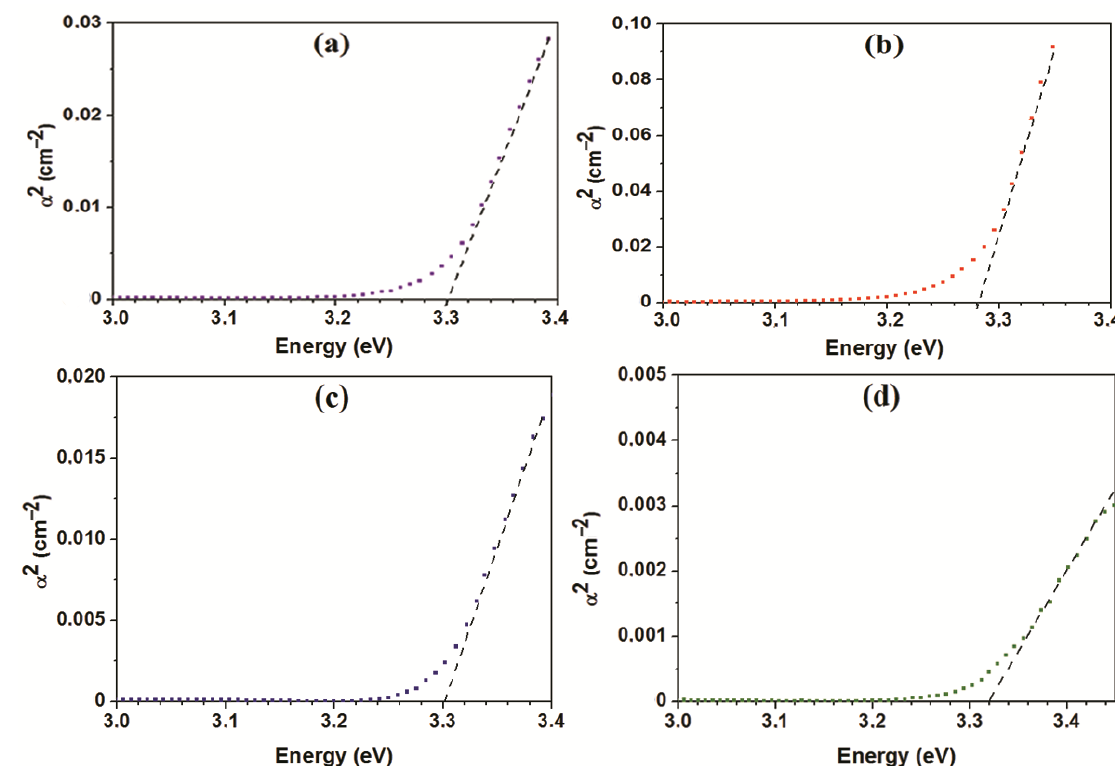
Figure 6. The estimation of the band gap for ZnO-SnO 2 materials: ZnO ( a ), Sn:Zn = 0.5:99.5 ( b ), Sn:Zn = 1:99 ( c ), Sn:Zn = 5:95 ( d ).